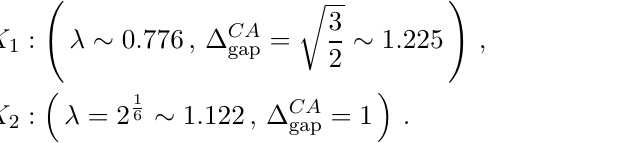
Figure 7. Left: the conformal moduli space M of the parametrized by the radius R and the B -(cid:12)eld b with periodicity b cal bootstrap bound on the lowest dimensional non-BPS operator in the chiral-antichiral channel (cid:1) CA of the four-point function gap on M (left) saturate region I, II, III, respectively, of the numerical bootstrap bound